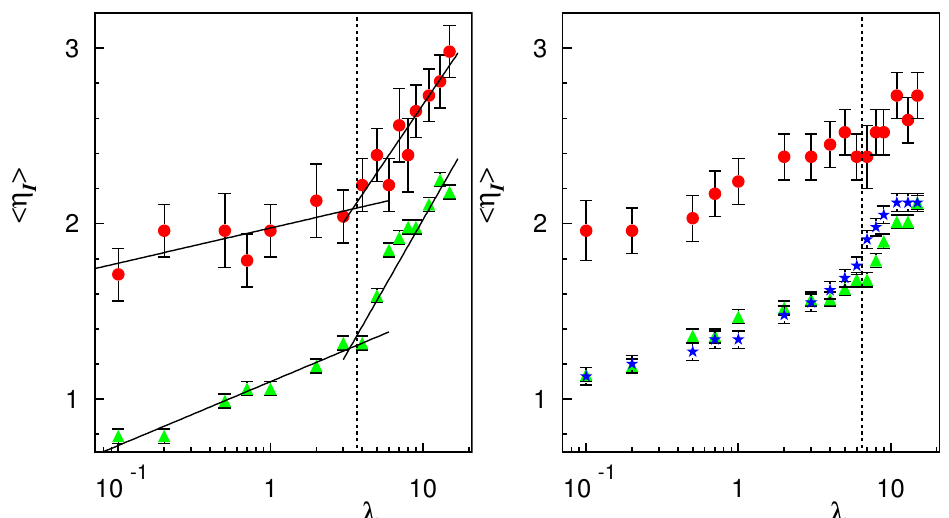
Figure 2. Average values of the intrinsic viscosity (cid:104) η I (cid:105) as a function of λ at S ∗ = 0.80 ( left ) and S ∗ = 0.95 ( right ) for κ / ( k B TR 0 ) = 6.58 ( • ), 65.8 ( (cid:78) ), 164.5 ( (cid:63) ). Full lines are guides to the eye. The tank-treading to tumbling transition occurs at λ c (cid:39) 3.7 for S ∗ = 0.80 and at λ c (cid:39) 6.5 for S ∗ = 0.95 in the Keller–Skalak theory [5] and is marked by the dashed vertical lines. Error bars are given by the root-mean-square fluctuation values of the intrinsic viscosity.